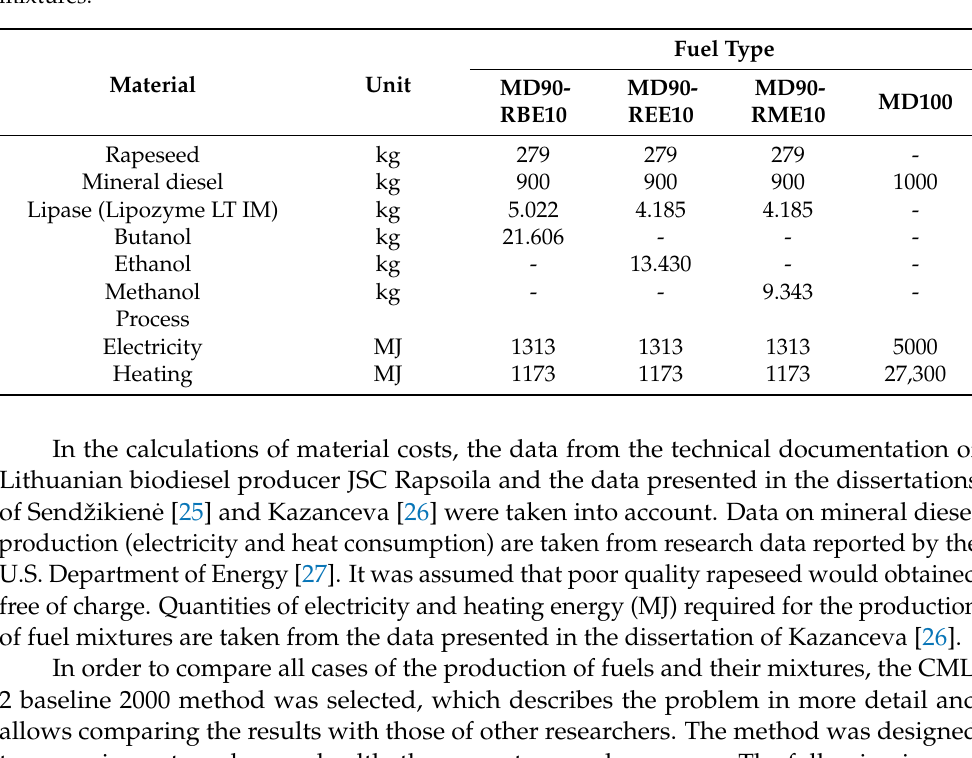
Table 1. Values of materials and processes in the life cycle analysis of pure mineral diesel and fuel